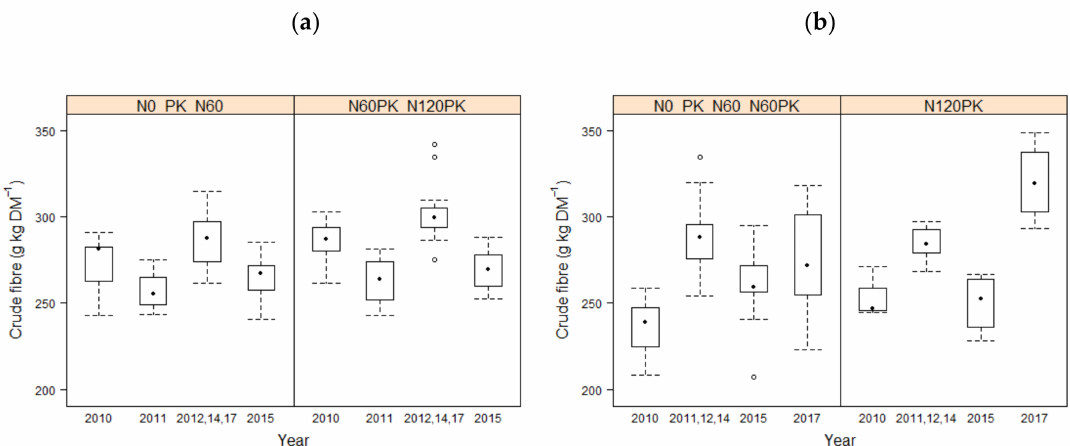
Figure 2. The minimal adequate model for the effect of fertilization treatment and time on the concentration of crude fiber (g kg DM − 1 ) for the first ( a ) and second ( b ) cuts with different fertilization treatments between 2010 and 2017 (except 2013 and 2016). Table 5. Effects of fertilizer and year on the metabolizable energy of the first cut in early June and the